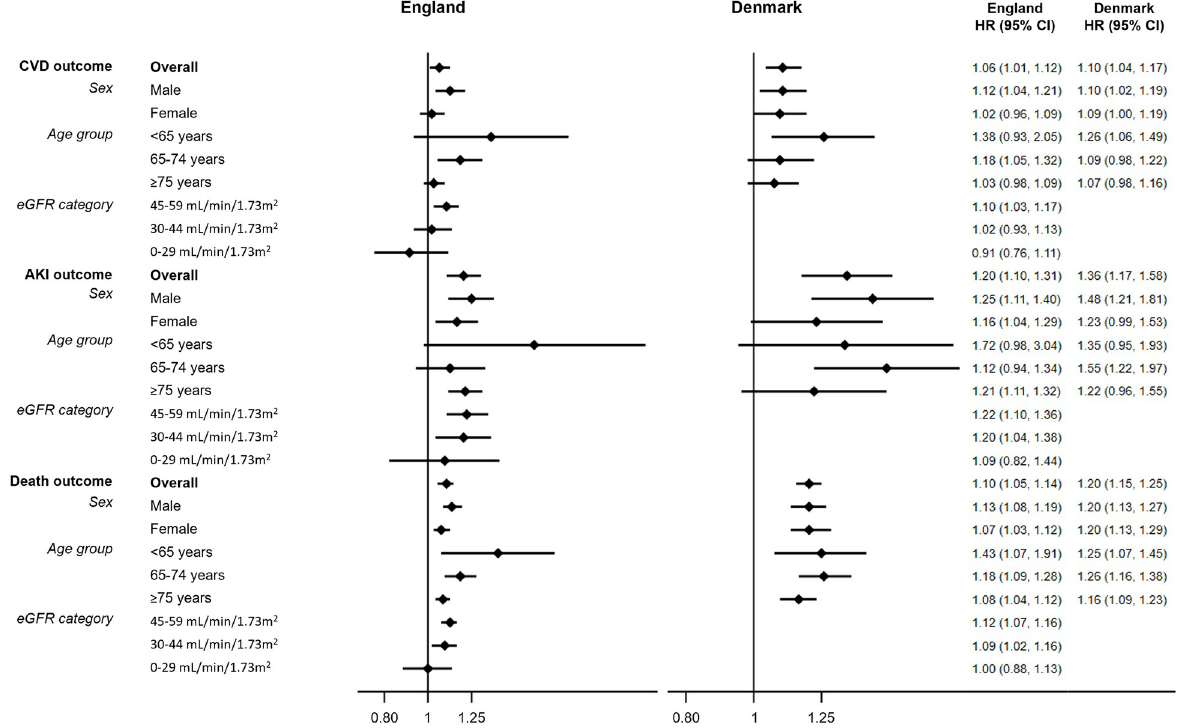
Fig 2. Forest plot showing adjusted HRs of CVD, AKI and death in bereaved persons with CKD compared to non-bereaved persons with CKD by sex, age-group, CKD stage (England